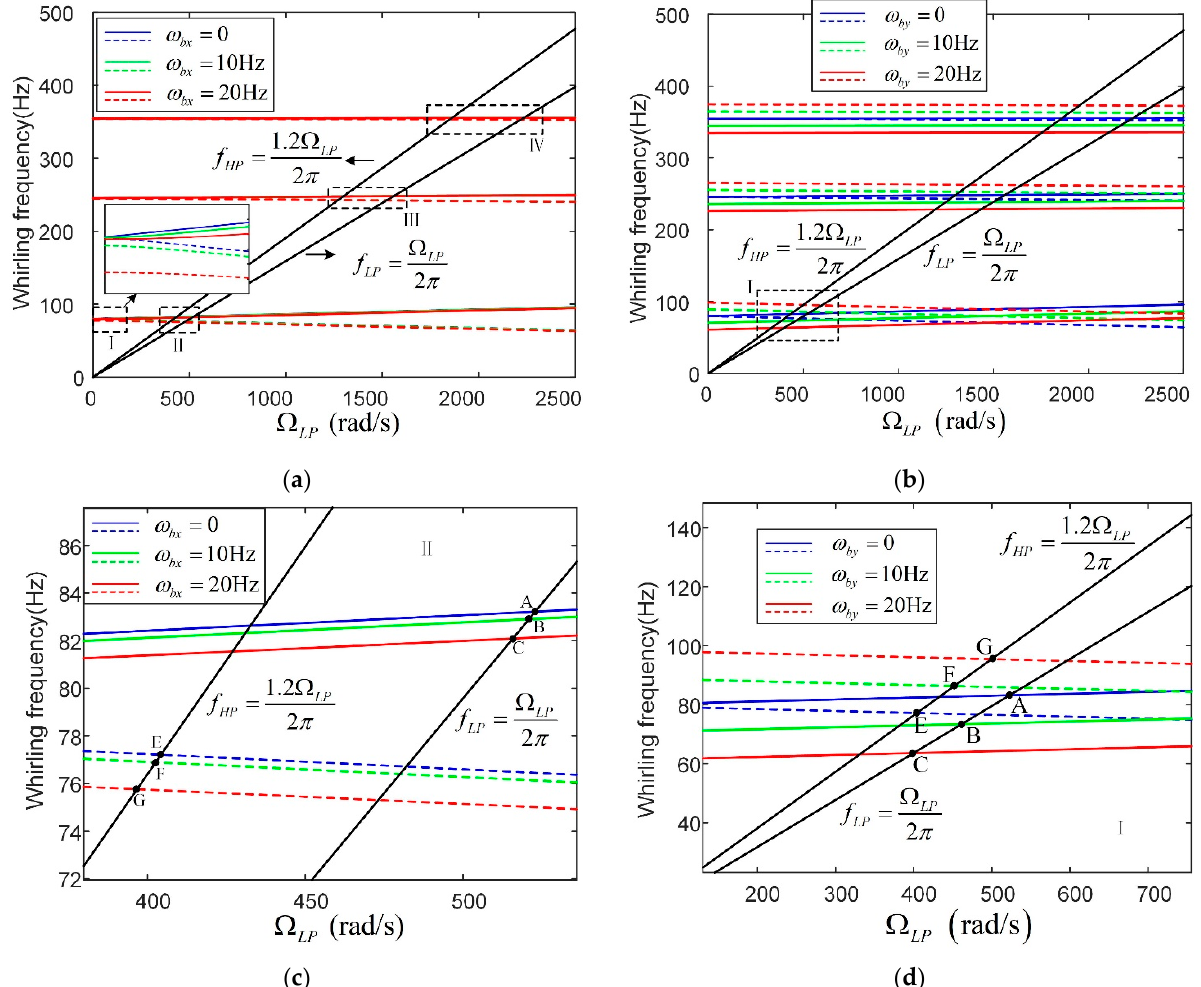
Figure 5. Campbell charts of the counter-rotating dual-rotor system with variable base rotations: ( a ) Pitching base motion; ( b ) Rolling base motion; ( c ) Zoom on Ⅱ in ( a ); ( d ) zoom on Ⅰ in ( b ).